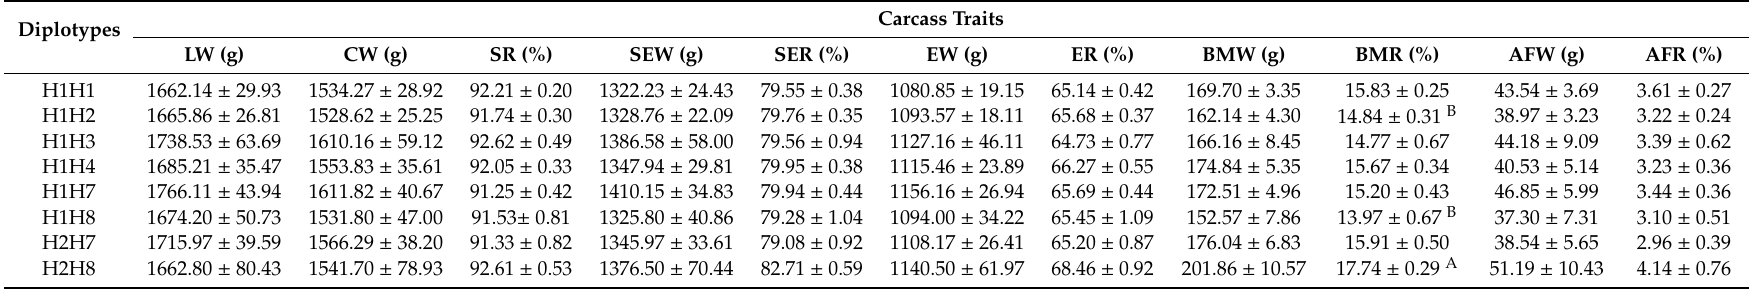
Table 8. Association of diplotypes of the PITX2 gene with carcass traits in Wuliang Mountain Black-bone chickens ( MEAN ± SE ).